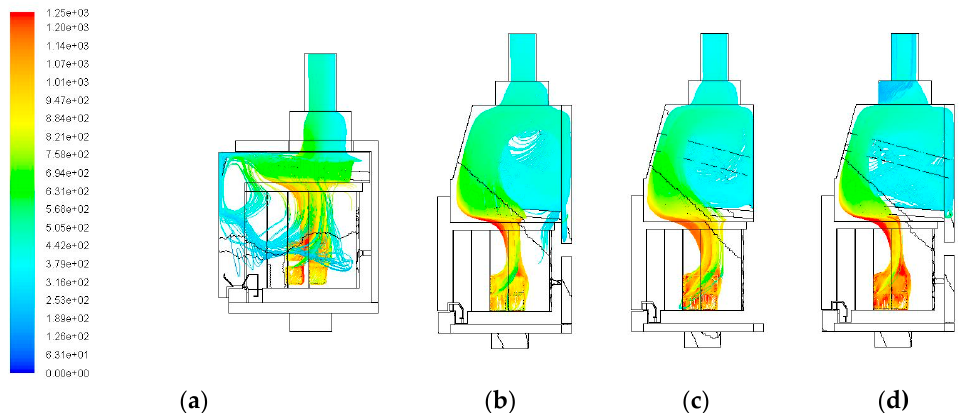
Figure 10. Path of the gas molecules and change of the temperature (°C) in the fireplace insert combustion chamber for: ( a ) Case 0, ( b ) Case 1, ( c ) Case 2, ( d ) Case 3.